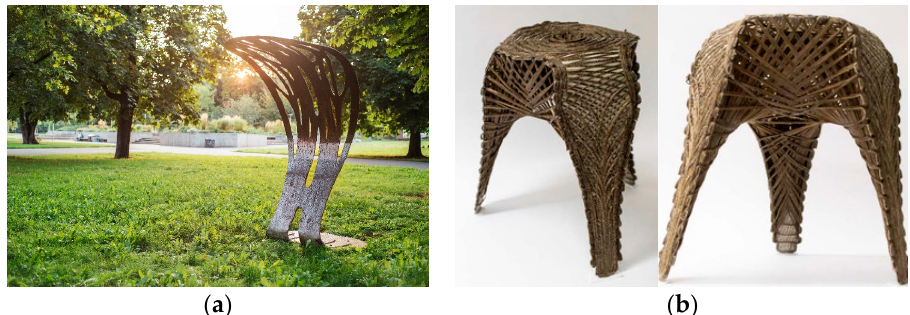
Figure 1. ( a ) Tailored biocomposite mockup by BioMat [26]; and, ( b ) “FlexFlax stool” [27].